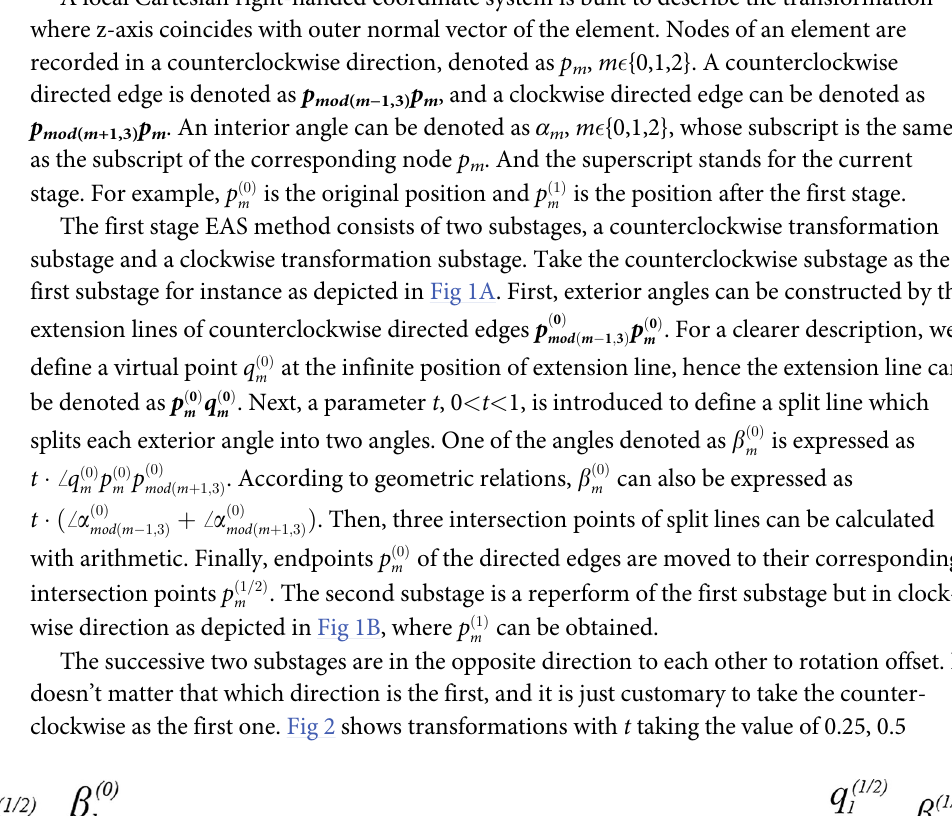
PLOS ONE | https://doi.org/10.1371/journal.pone.0232854 May 12,